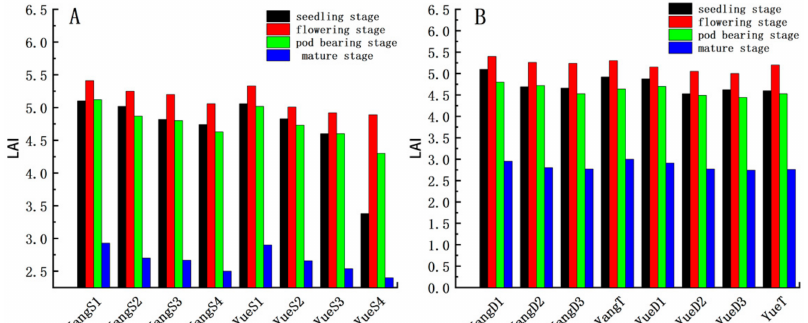
Figure 5. LAI for two peanut varieties under single sowing ( A ), and LAI for two peanut varieties under double sowing ( B